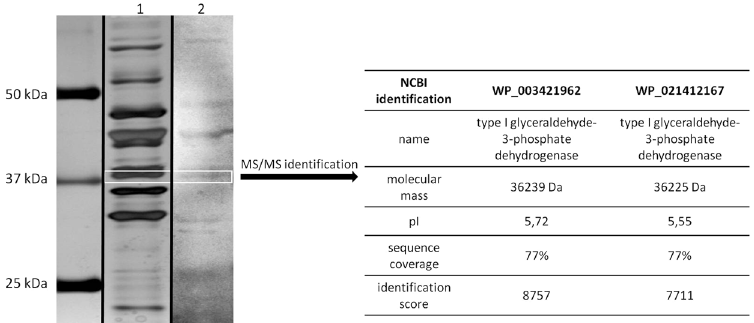
Figure 1. Results of protein isolation and identification. Proteins were extracted using 1 M LiCl, separated in 12,5% gels SDS-PAGE and silver-stained, lane 2. Separated proteins were analyzed by Western blot using umbilical cord blood pooled sera, lane 3. Full-length uncropped gel and blot are included in Supplementary Figs 1 and 2. The white box indicate band selected for MS/MS identification. Results of protein identification are showed in the table on the